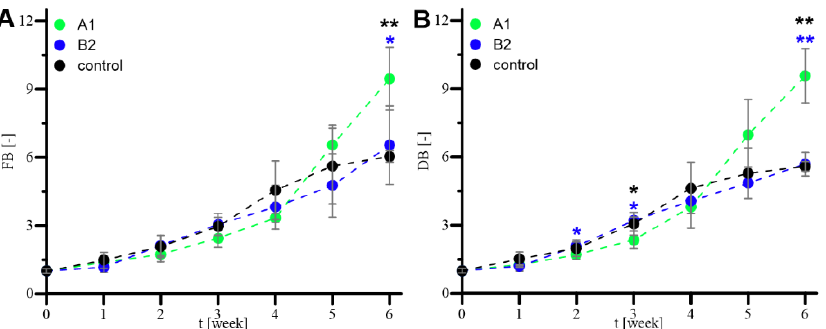
Figure 8. The values of FB ( A ) and DB ( B ) obtained for samples harvested daily from the prolonged 42-day (i.e., 6-week) cultures of R. graeca hairy roots supported with gels A1 or B2 and for the control culture. The asterisks mark the cultures at which the determined values of parameters were statistically different from the values characterizing the reference culture. The color of the asterisks is consistent with the color of the markers identifying the experimental data. The number of asterisks is related to the value of p ( p < 0.05 (*) and p < 0.01 (**)) determined according to the ANOVA test.